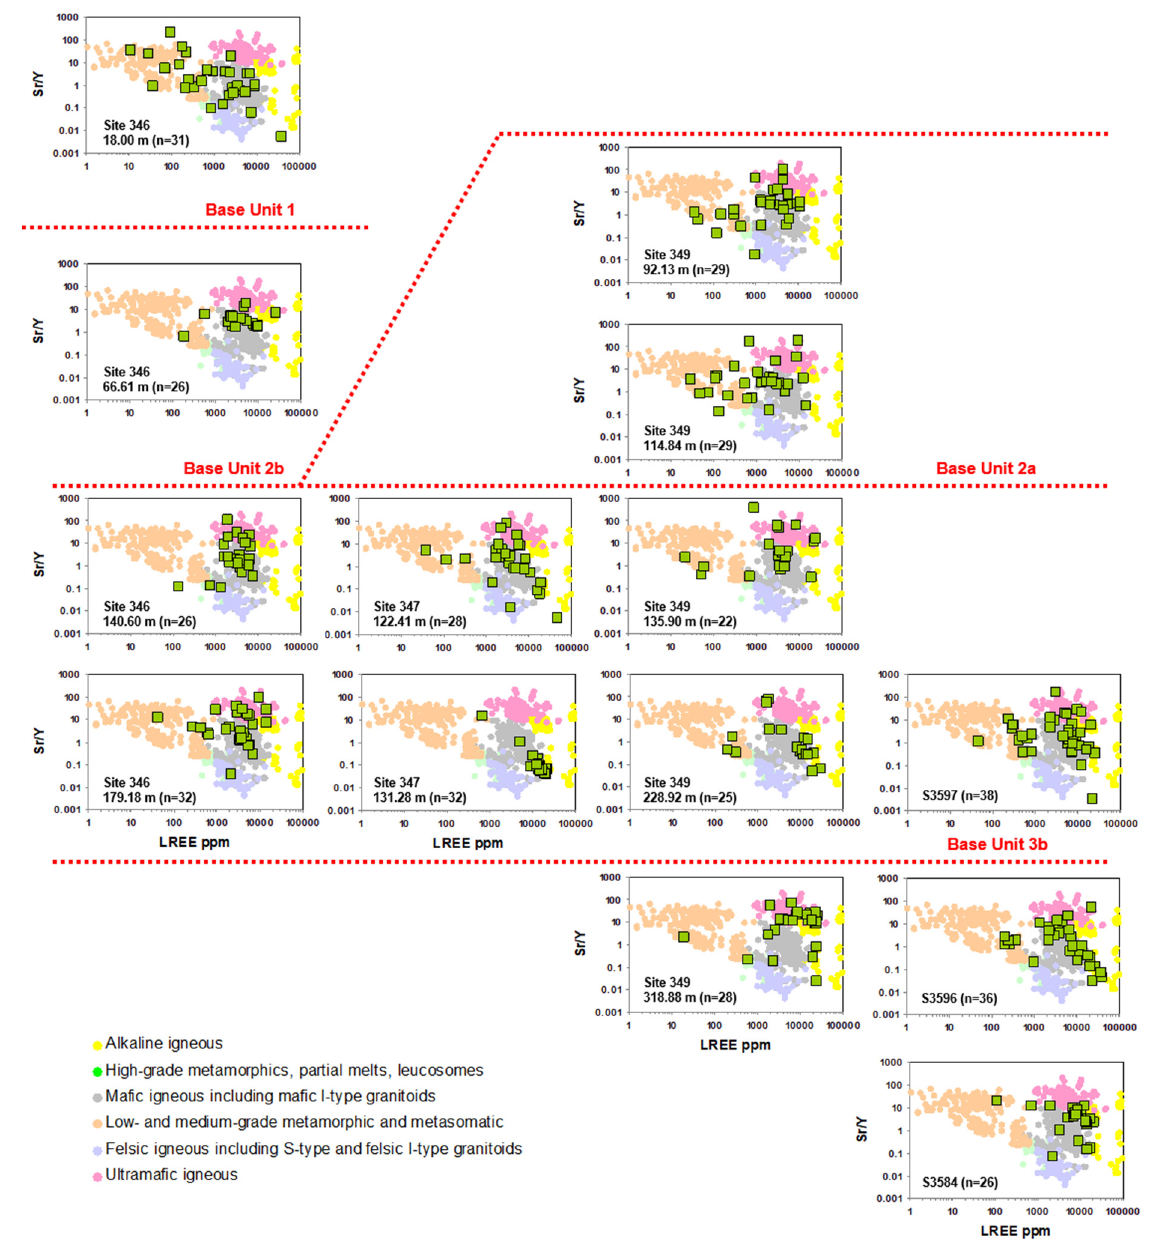
Figure 13. Detrital apatite compositions from the Jan Mayen Ridge and Kap Brewster plotted on the Sr/Y-LREE diagram of O’Sullivan et al. [45], showing the range of stratigraphic and regional variations in apatite provenance.